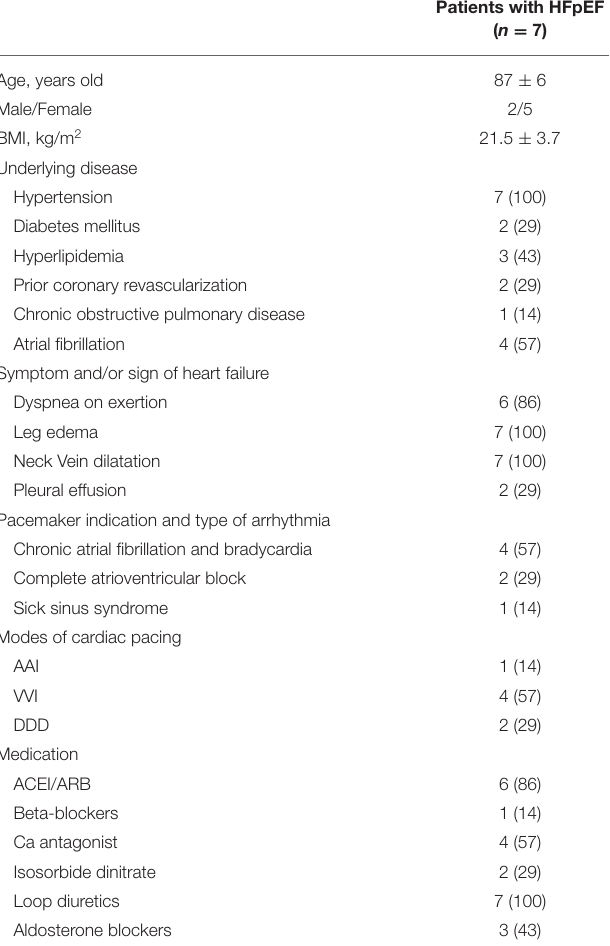
TABLE 4 | Clinical features in patients with HFpEF and deep Y descent on the day of heart rate modification.